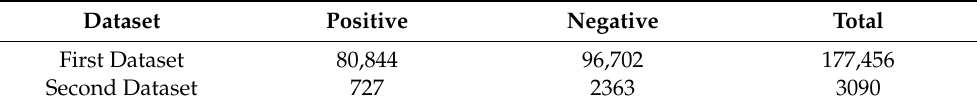
Table 1. Summary of